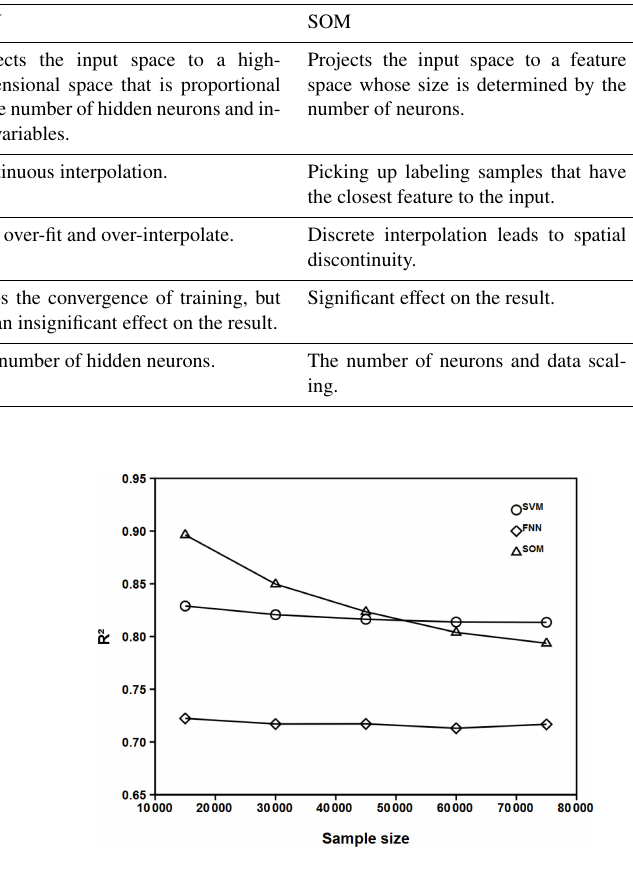
Figure 1. Correlation coefficient between modeled and observed f CO 2 (uatm). The sample size is the number of data points ran- domly selected to train FFN and SVM and to label